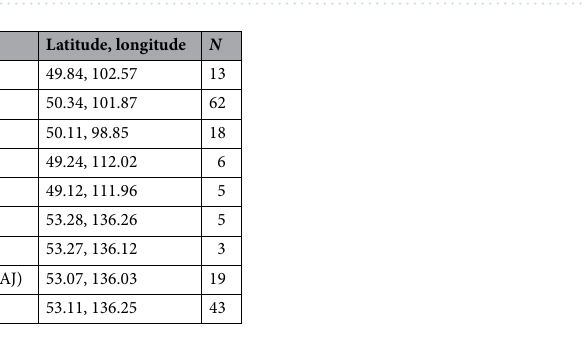
Figure 1. Map illustrating the main drainages from which taimen were sampled from Mongolia and Russia. One Arctic (purple) and two Pacific (green) drainage sampling sites ( a ). The red rectangle denotes the Tugur basin sampling area, shown in greater detail ( b ). Sampling sites correspond to those in Table 1 and include the Delgermörön (DL), Eg (EG), Uur (UR), Lower Onon (LO), Upper Onon (UO), Tugur (TU), Konin/Assyni Junction (AJ), Konin (KO), and Munikan (MU) sampling sites. A recently released taimen rests in the flooded grassland ( c ). Panels ( a ) and ( b ) were modified using Adobe Creative Suite.